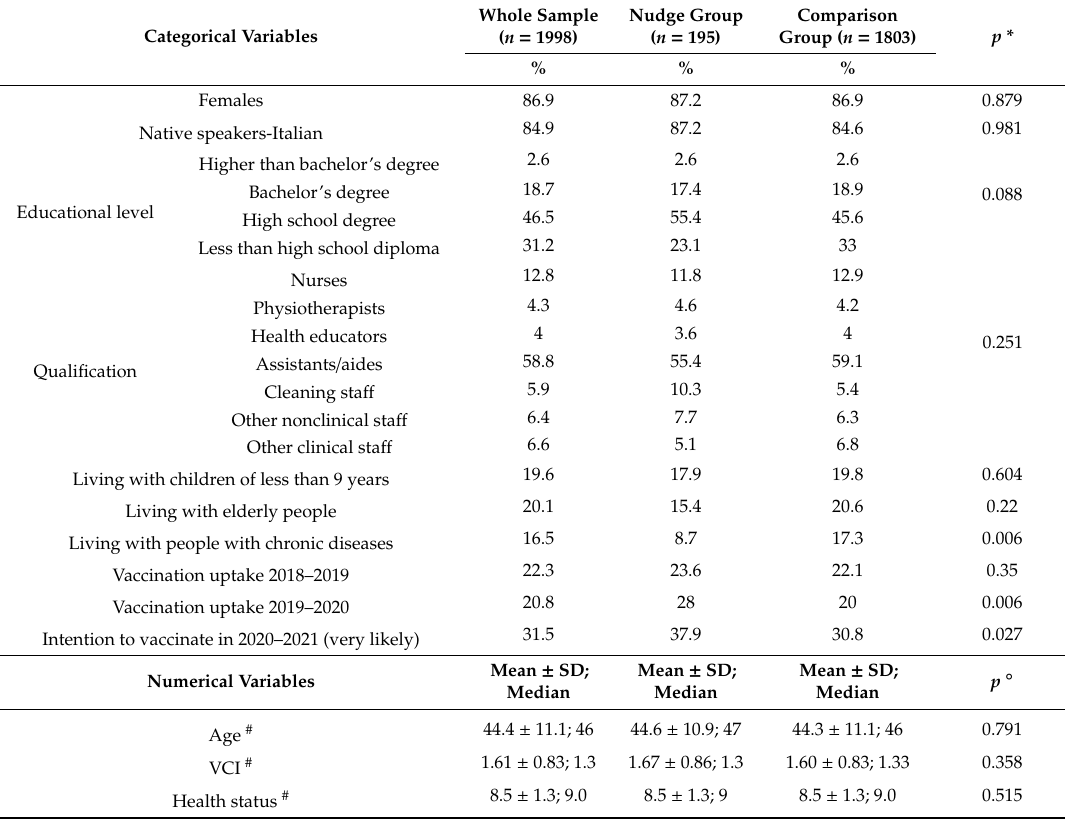
Table 3. Descriptive analysis of the collected variables by group. VCI: Vaccine Confidence Index, SD: standard